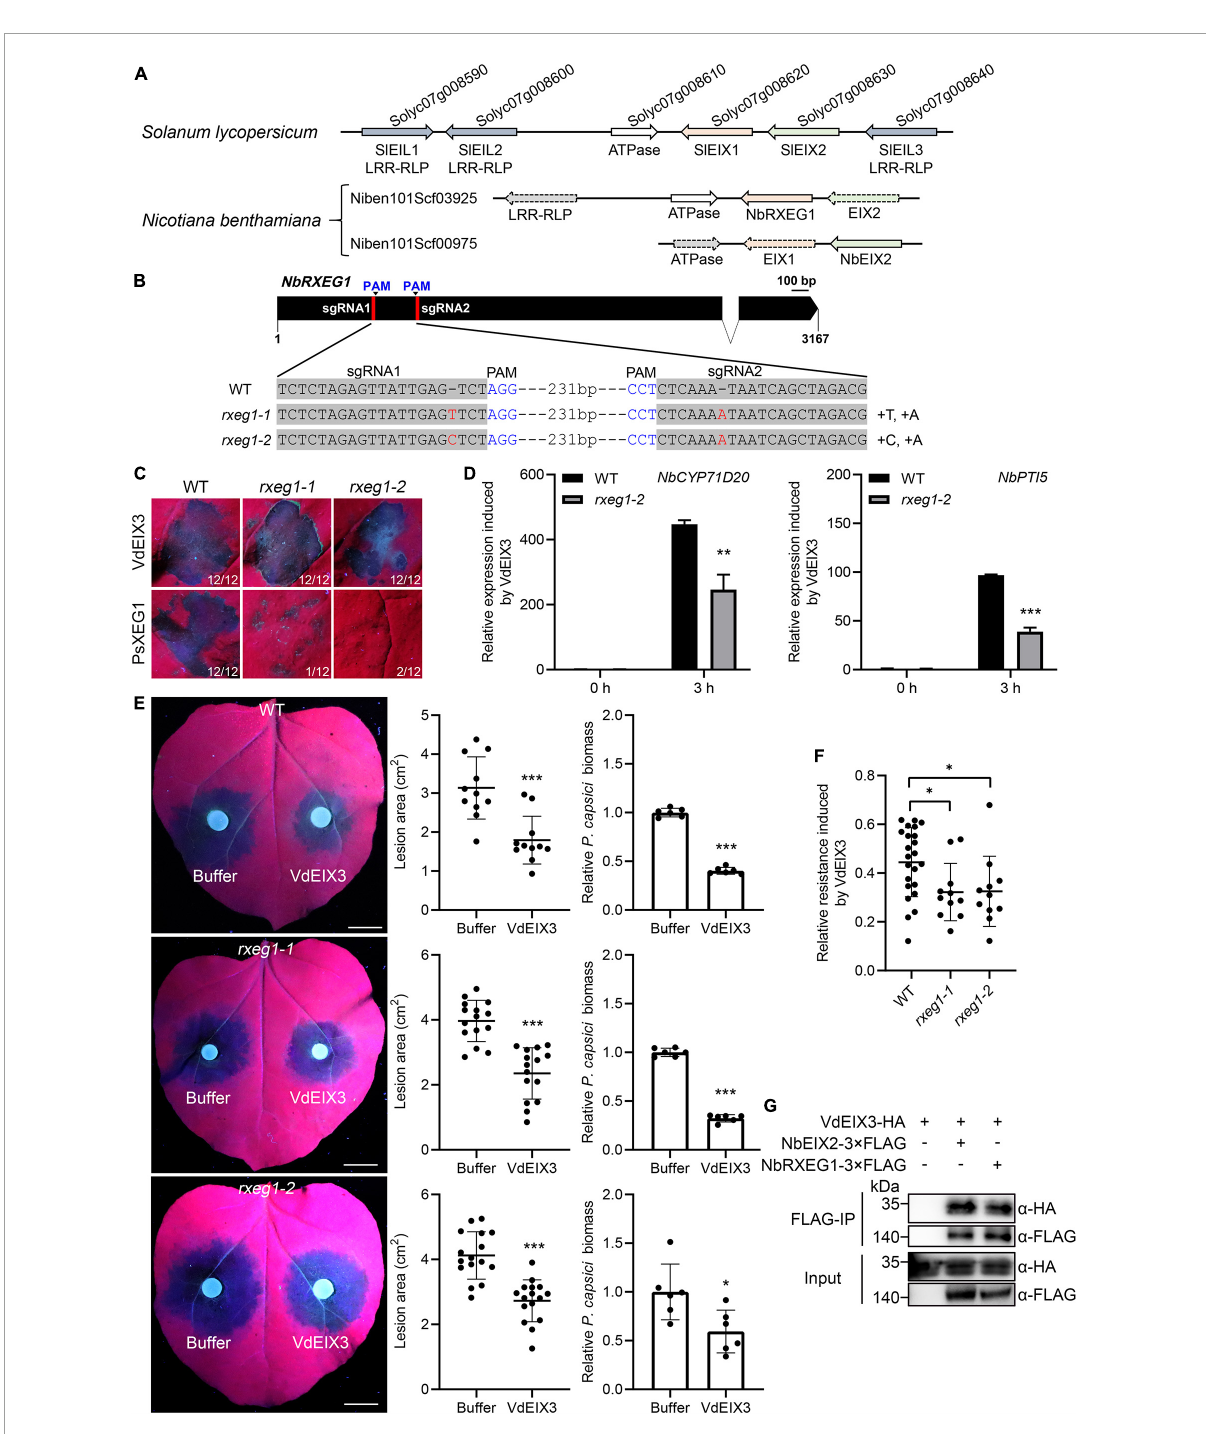
FIGURE4 NbRXEG1 is also involved in the VdEIX3 recognition by Nicotiana benthamiana . (A) NbEIX2 homologs in the EIX-responding locus of tomato and N. benthamiana . The dotted arrow indicates pseudogene. (B) Sequence alignment of the regions in rxeg1 targeted by sgRNAs. (C) VdEIX3 induces cell death in rxeg1 mutants by agroinfiltration. The photos were taken 3 days post infiltration under white and UV light, respectively. (D) The transcript levels of NbCYP71D20 and NbPTI5 were reduced by half in the rxeg1-1 mutant. Data are shown as mean ± SD (Student’s t -test, ** P < 0.01). (E) VdEIX3-induced resistance to Phytophthora capsici was impaired in rxeg1 mutants. Bars, 1 cm. Data are shown as mean ± SD (Student’s t -test, *** P < 0.001). (F) Relative resistance-induced by VdEIX3 protein was lower in eix2 mutants than that in wild-type N. benthamiana . Data are shown as mean ± SD (Student’s t -test, * P < 0.05). (G) NbRXEG1 associates with VdEIX3 in co-immunoprecipitation (Co-IP) assay. VdEIX3-HA was co-expressed with NbRXEG1-3xFLAG in N. benthamiana . The immunoprecipitated product obtained by anti-FLAG beads was analyzed by immunoblot with anti-FLAG or anti-HA